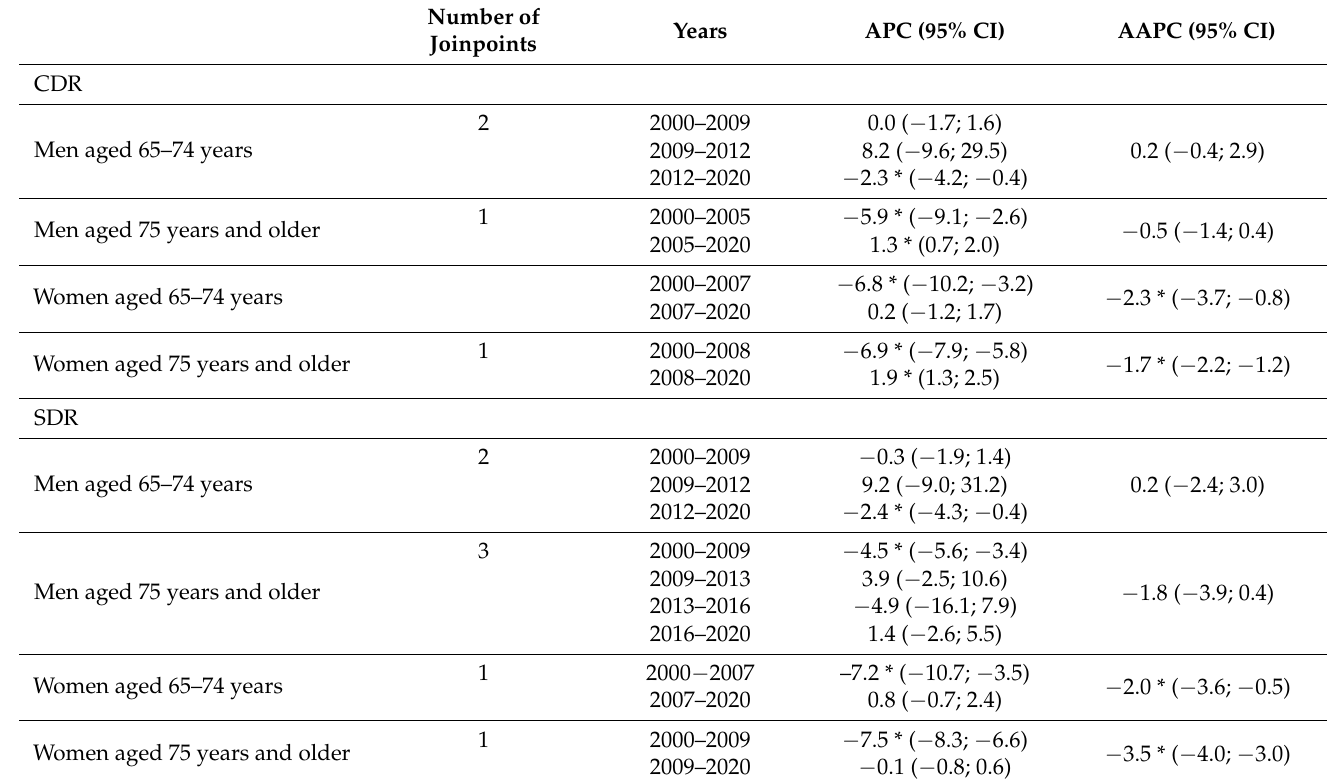
Figure 2. Trends of standardized death rates due to falls in people aged 65–74 years and 75 years and older in Poland in 2010–2020. Source: own calculations.